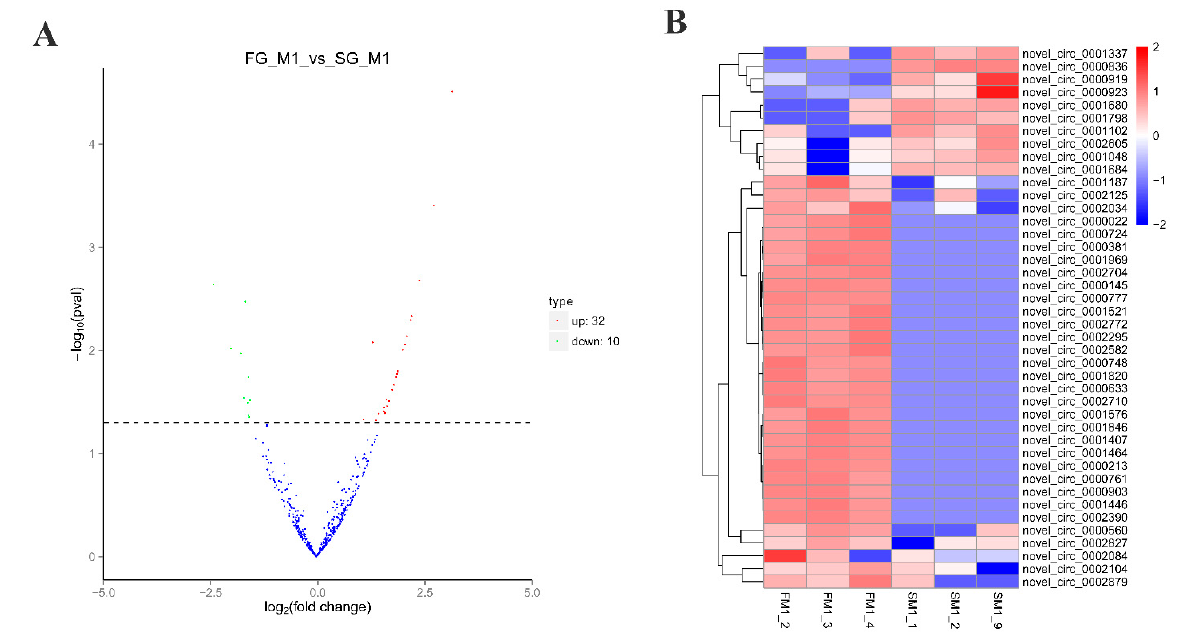
Figure 3. DE circRNAs in FG vs. SG of M. amblycephala . ( A ) Volcano map of DE circRNAs. Note: Volcano plot showing p values ( − log10) versus circRNAs ratio of FG/SG (log2). Up-regulated and down-regulated circRNAs are shown in red and green, respectively. Blue dots represent circRNAs with no significant difference. The significance level was indicated as p < 0.05. ( B ) Clustered heat map of DE circRNAs. The sample is represented by the abscissa and the log value of circRNA expression is regarded by the ordinate, which means that the heatmap is drawn from log10 of circRNA expression. The highly expressed circRNA is indicated by red, meanwhile, the lowly expressed circRNA is represented by blue .